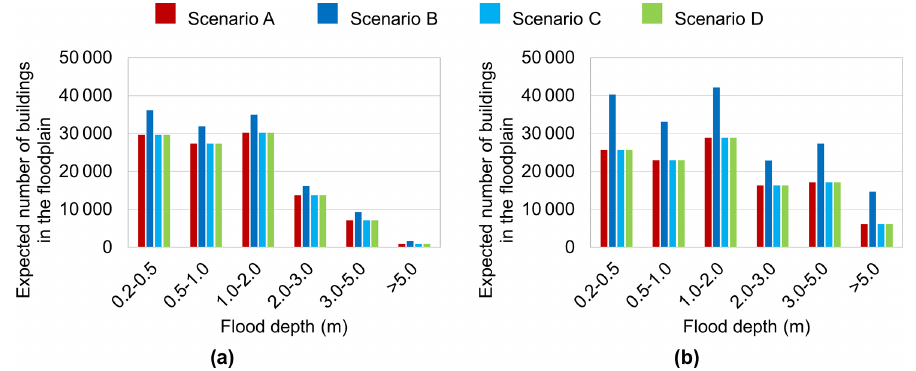
Figure 6. Exposure to flooding: the expected number of buildings within a given range of flood depth per flooding occurrence ( a : 100-year; b : 1000-year) and exposure scenario. Table 2. Exposure to flooding: proportions of the total building stock within a given range of flood depth per flooding occurrence and exposure